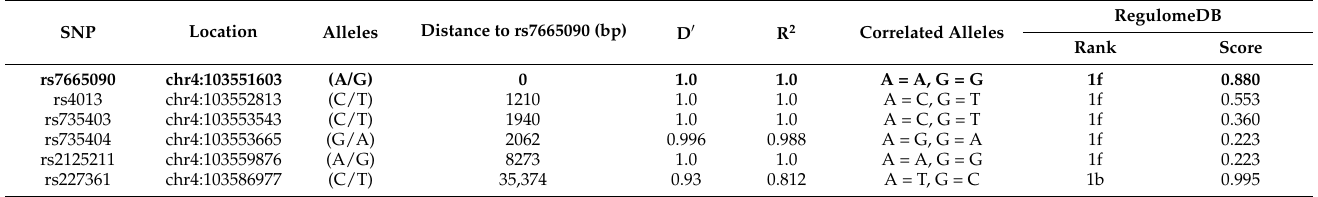
Table 1. Analysis of rs7665090 (highlighted in bold letters) and nearby proxies according to Reg- ulomeDB data. 1b: Likely to affect binding and linked to expression of a gene target (eQTL + TF binding + any motif + DNase Footprint + DNase peak); 1f: Likely to affect binding and linked to expression of a gene target (eQTL + TF binding/DNase